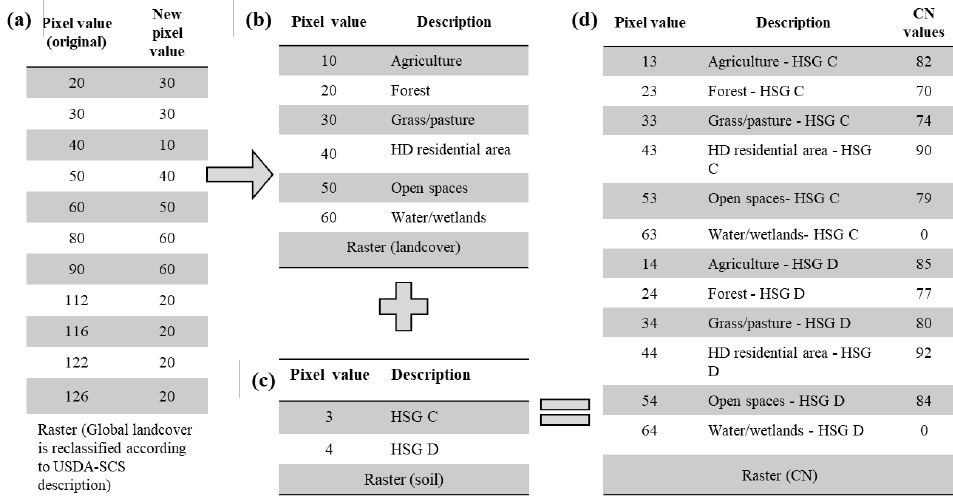
Figure 4. Process of CN raster creation from the landcover and HSG raster datasets. ( a ) The landcover raster is regrouped into landuses based on Table 2 and reclassified with new pixel values. ( b ) The reclassified landcover raster and its description. ( c ) The soil raster with its raster value added to the landcover raster in ( b ). ( d ) The sum of landcover and soil rasters reclassified according to the appropriate CN values of Table 2.